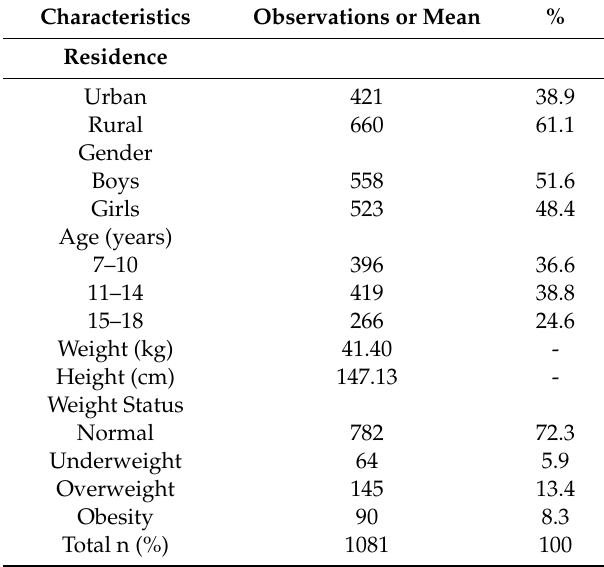
Table 1. Basic characteristic of the school-age